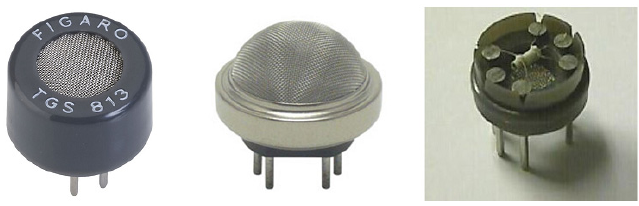
Figure 3. Modern commercial TGS-based gas sensors photos, from Refs. [20–22].